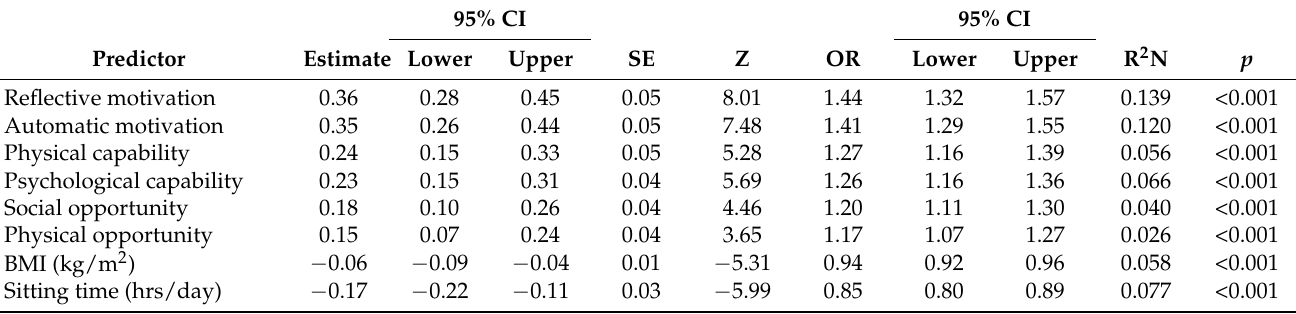
Table 4. Ordinal logistic regression and predictive ability for physical activity classification (low; moderate; high) based on the International Physical Activity Questionnaire